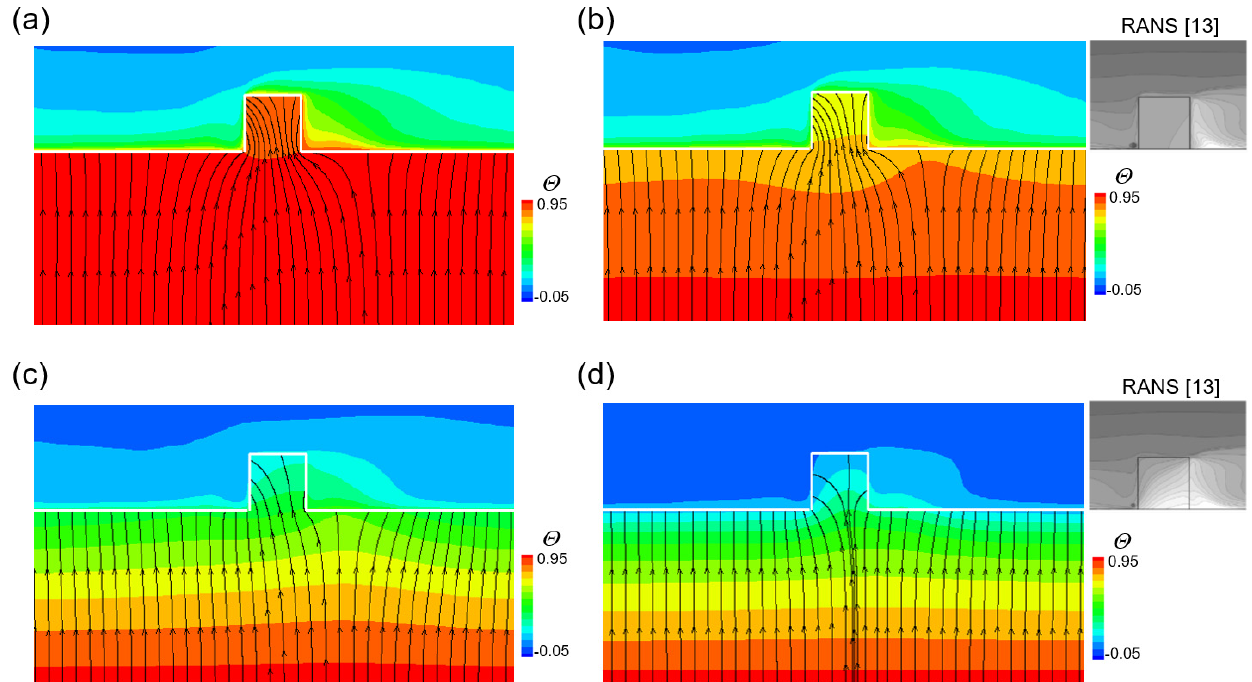
Figure 4. Heat flux vectors inside the solid wall: ( a ) K* = 566.26, ( b ) K* = 100.00, ( c ) K* = 10.00, and ( d ) K* = 1.00.